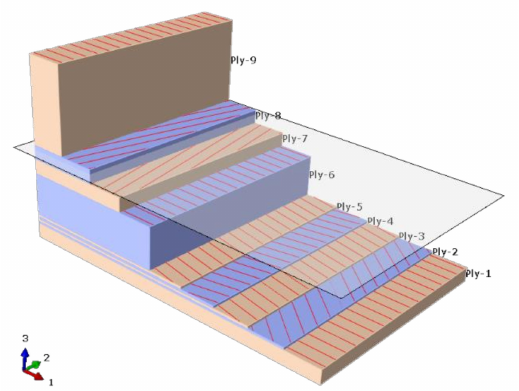
Figure 6. Example of a layered structure shell element: SH-120 element (#9) group with 9